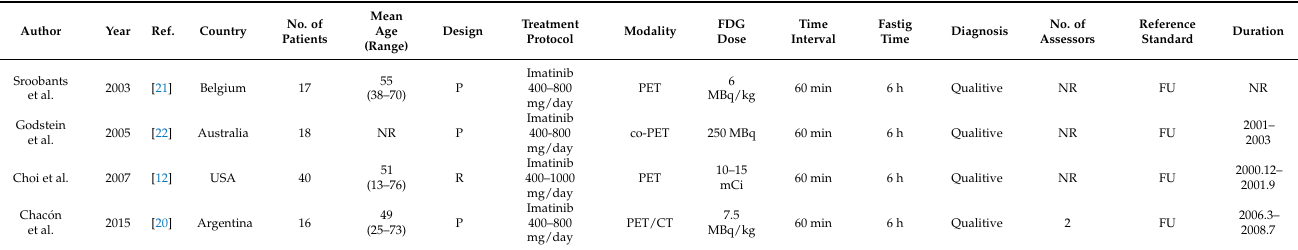
Table 1. Study characteristics for selected